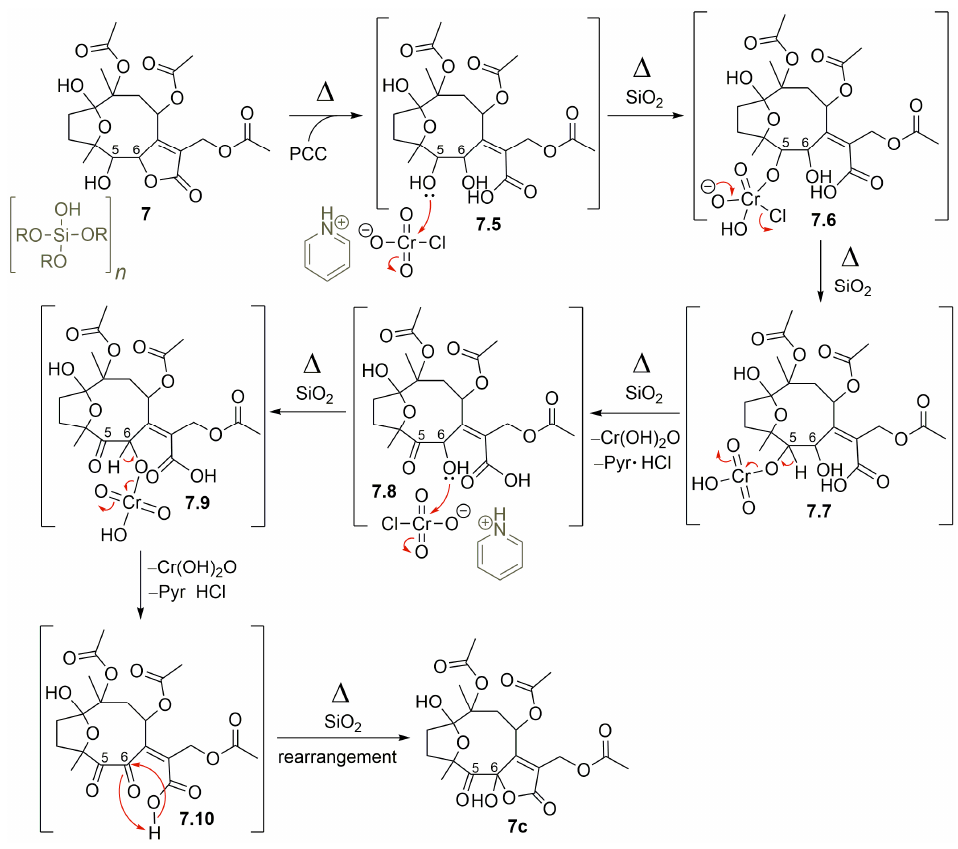
Figure 10. Proposed mechanism for the formation of SL semisynthetic derivative 7c (red arrows illustrate the arrow-pushing mechanism).